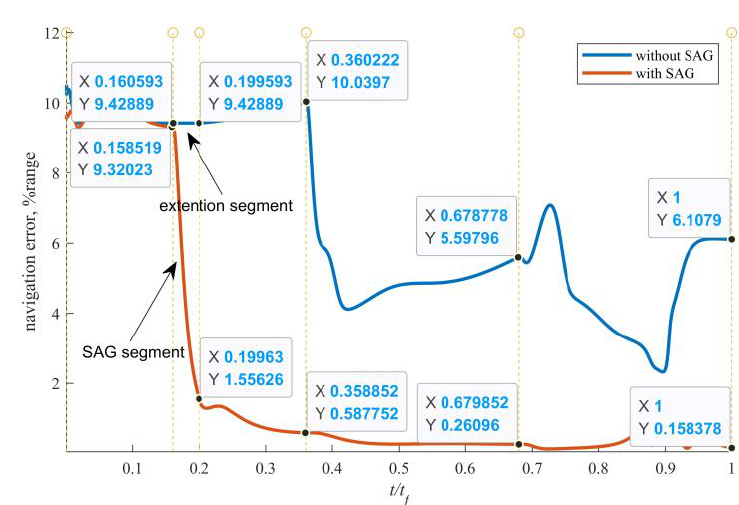
Figure 11. AON position error (%range) with and without SaG.